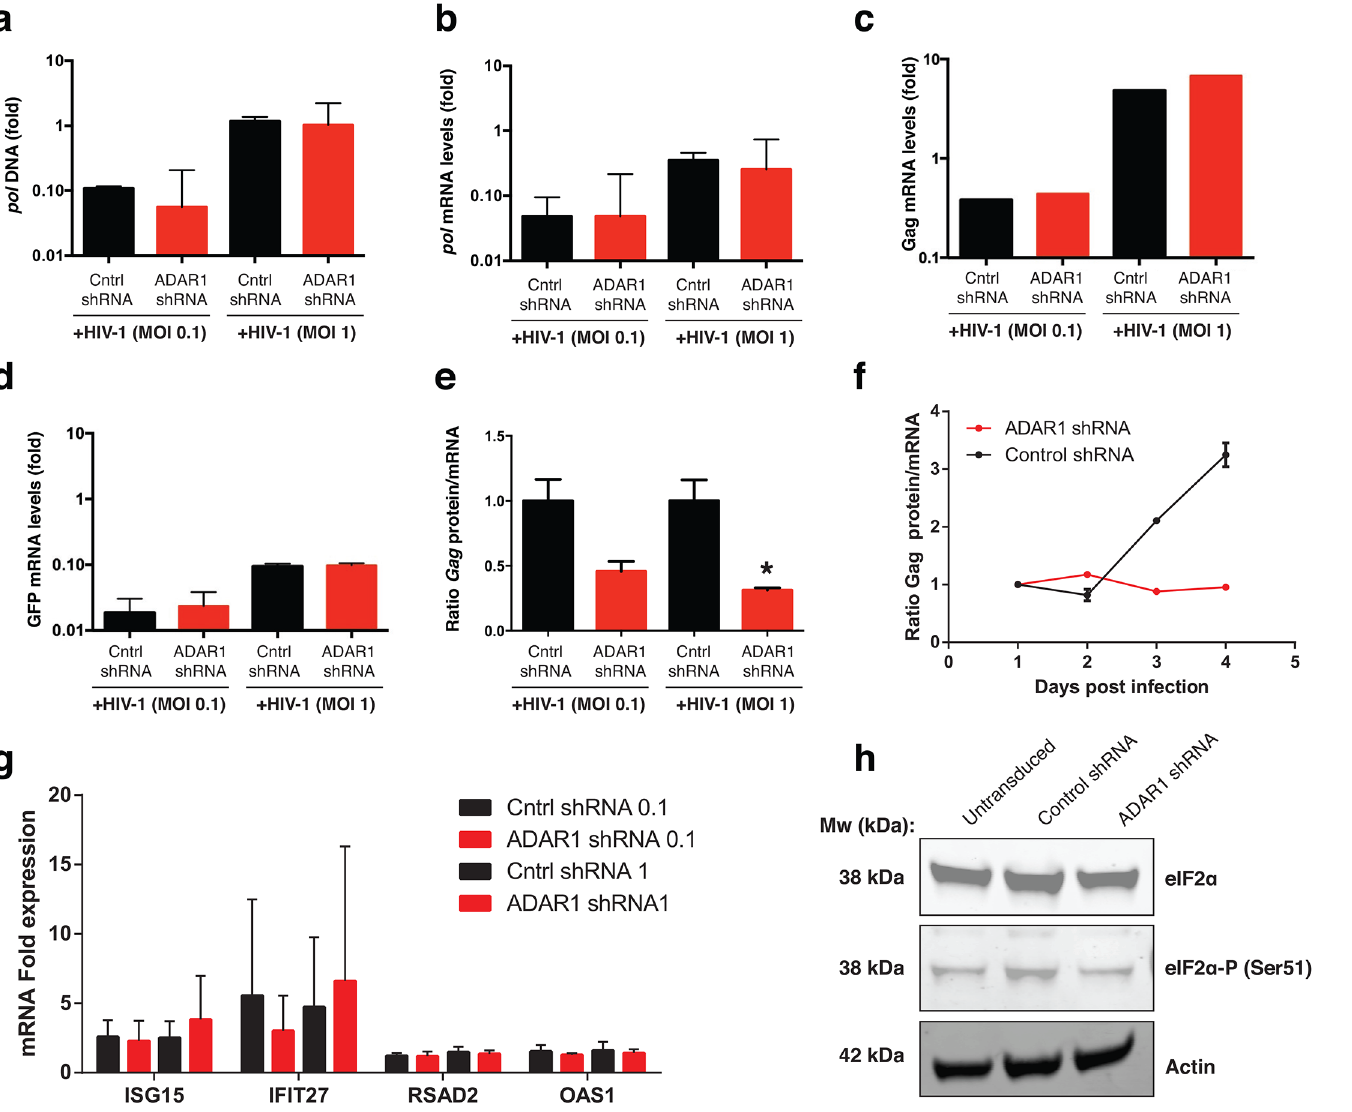
Fig 3. Relative quantification (mean ± s.e.m) of viral DNA pol (a) and viral pol mRNA (b) expressed as fold versus NT-shRNA control cells (n = 3). (c) Gag (n = 2) and (d) GFP (n = 3) mRNA expressed as fold versus NT-shRNA control cells (e) Bar graphs show the ratio of Gag protein versus Gag mRNA levels on infected cells (n = 3), * P < 0.05. (f) Time course ratio expression of Gag protein versus Gap mRNA from day 1 to day 5 after infection (n = 2 =). (g) Relative quantification of ISG15, IFIT27, RSAD2, IFIT44L, and OAS1 of control shRNA and ADAR1 shRNA cells. (h) Western blot of eIF2 α and the phosphorylated form of eIF2 α . Actin was used as loading control.